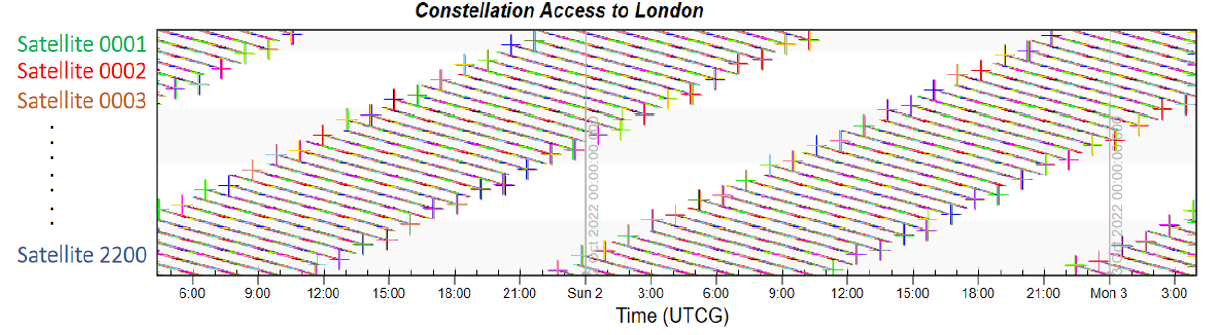
Figure 11. Constellation access to London.